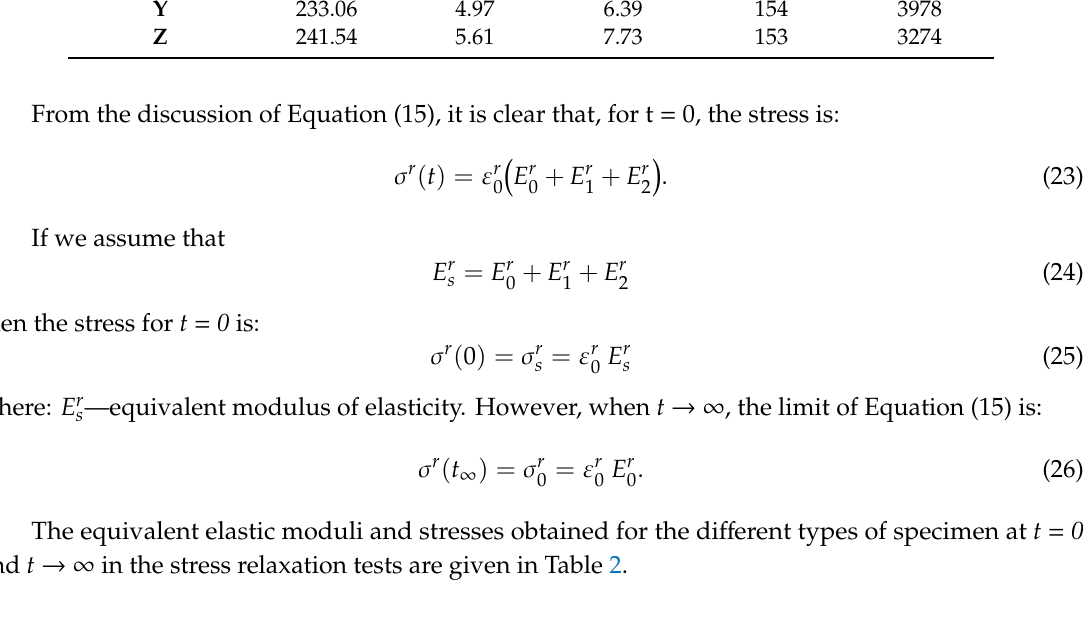
Table 2. Equivalent elastic moduli and stresses for t = 0 and t → ∞ .